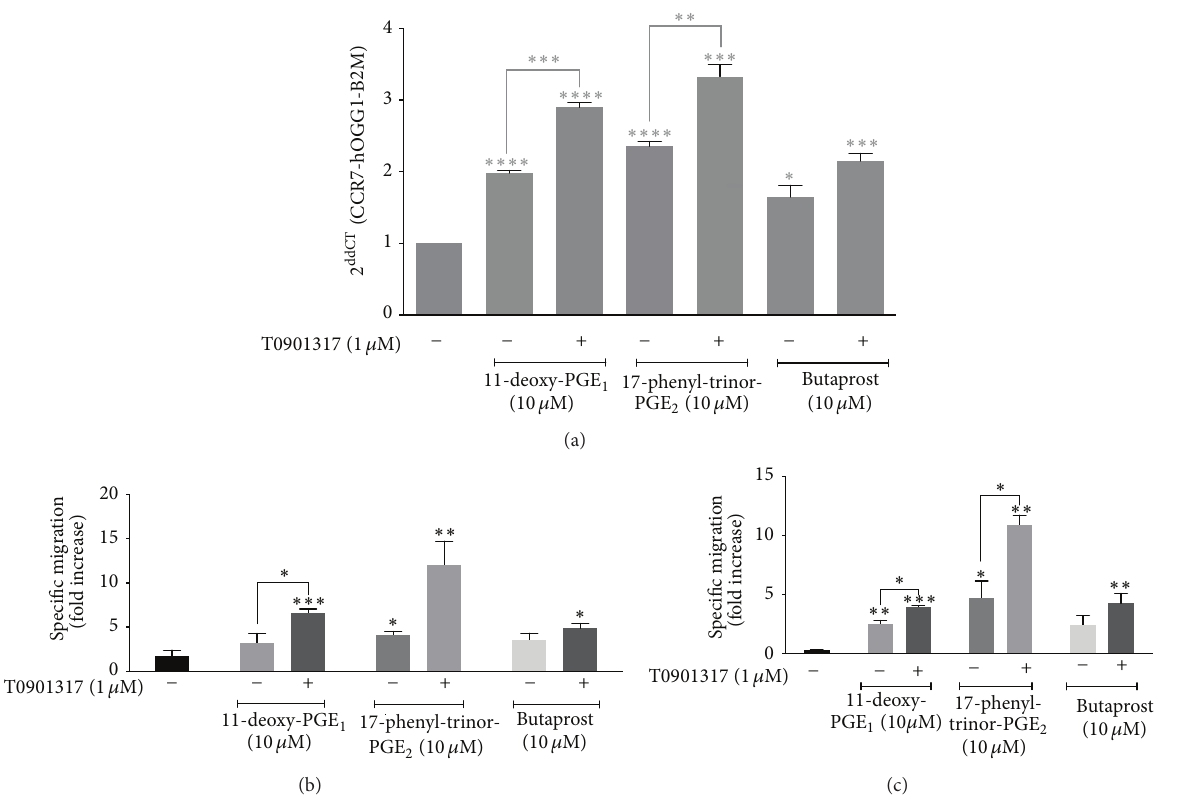
Figure 5: Functional migration in response to PGE 2 and T0901317 is dependent on EP 2 and EP 4 receptors in MM-1 cells. (a) MM-1 cells were treated for 8h (filled black) and 24 h (filled gray) with the indicated concentrations of 11-deoxy-PGE 1 , 17-phenyl-trinor-PGE 2 , and butaprost. Total RNA was extracted and CCR7 transcripts were detected using real-time qPCR. Data represent mean ± SD of three independent experiments. Chemotaxis assays in response to 300 ng/mL CCL19 (b) or CCL21 (c) were performed using MM-1 cells stimulated for 48 h with 1 𝜇 M T0901317. The mean number of spontaneously migrating cells (that migrated to media alone) was subtracted from the number of cells that migrated in response to CCL19. Data represent mean ± SD of three independent experiments. ∗ 𝑝 < 0.05 , ∗∗ 𝑝 < 0.01 , ∗∗∗ 𝑝 < 0.001 , and ∗∗∗∗ 𝑝 < 0.0001